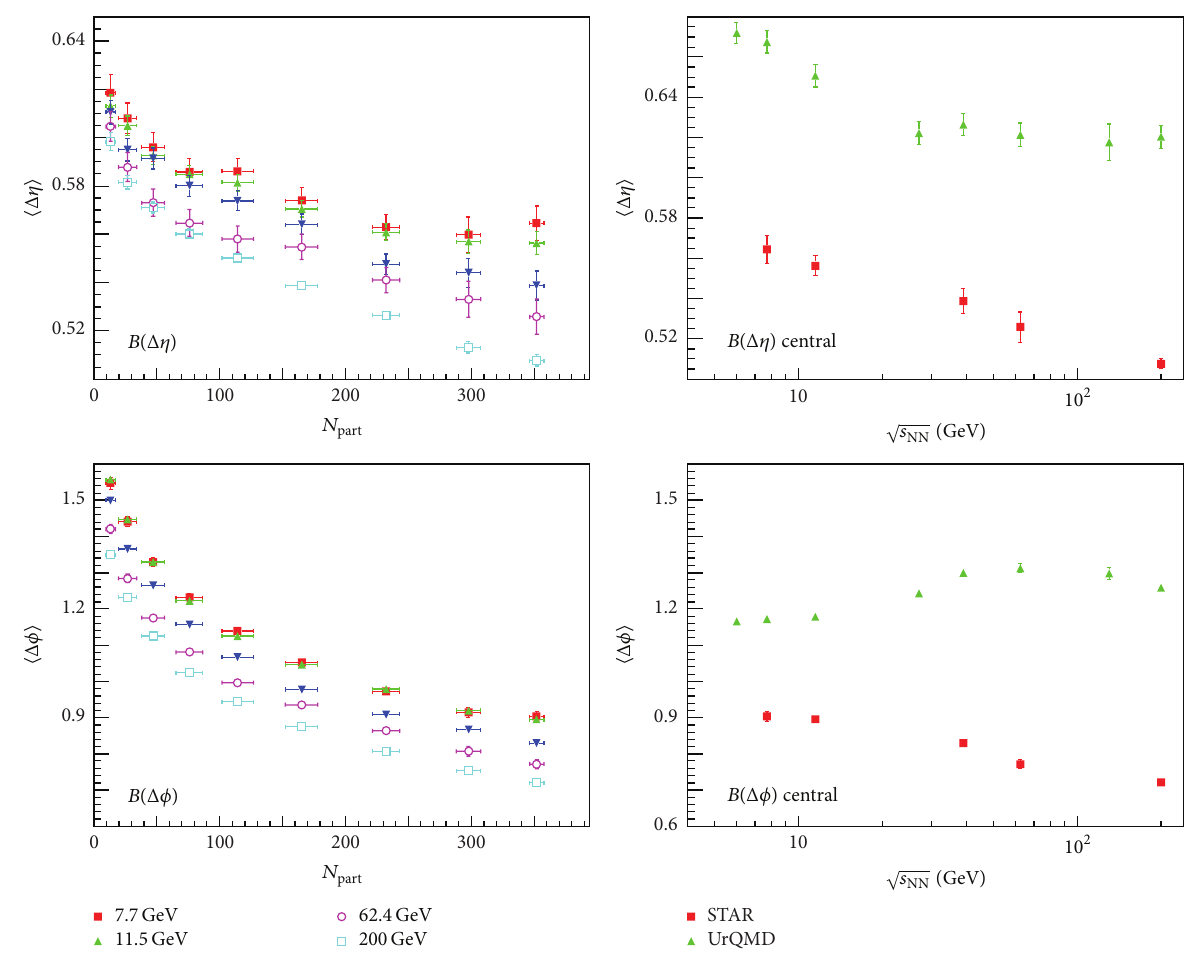
Figure 9: The widths of balance functions are given as functions of Δ𝜂 , Δ𝜙 for all charged particle pairs from Au+Au collisions. Left-hand panel shows centrality dependence, while the right-hand panel shows beam energy dependence of most central events (0–5%). The graph is taken from